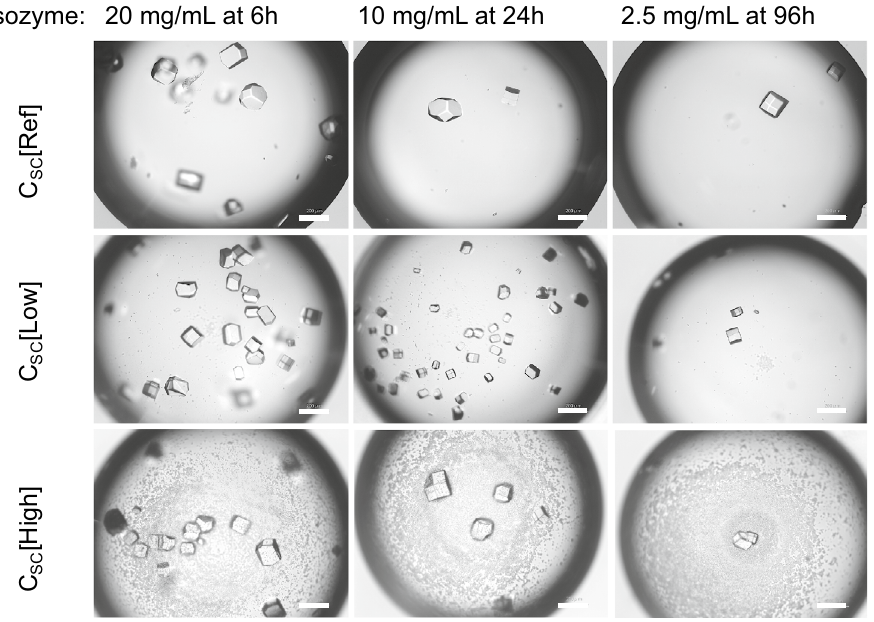
Figure 1. Microscope images of some droplets with the C Lys of 20, 10 and 2.5 mg/mL and with three different concentrations of biotemplates. Scale bars are 200